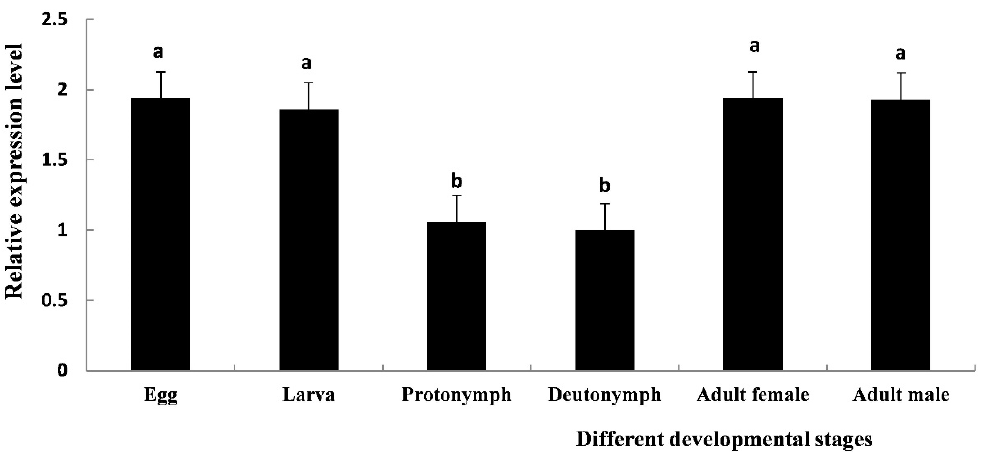
Figure 4. The relative mRNA expression level of TcCHS1 at different developmental stages of T. cinnabarinus was determined by real-time quantitative PCR (RT-qPCR), including eggs, larvae, protonymphs, deutonymphs, adult females and adult males. The β -actin gene of T. cinnabarinus was used as a reference gene. Each value is represented as the mean ( ± SE) of four replications. Means within the same column followed by the same lowercase letter(s) are not statistically significant different using Duncan’s test at a 95% level of confidence ( p < 0.05).